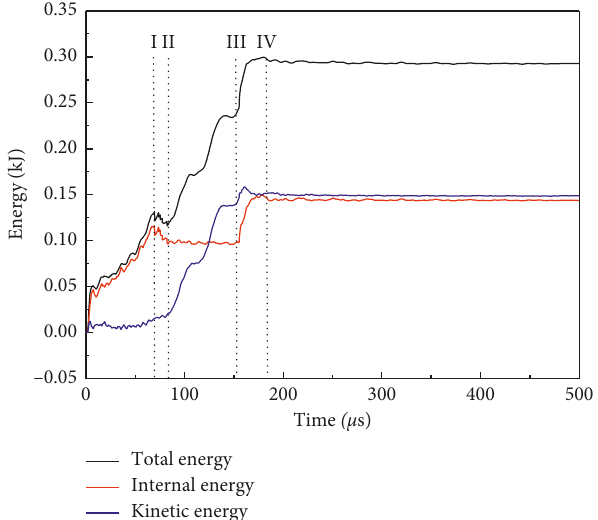
Figure 24: Energy histories of the body at 442 ° mg charge amount.